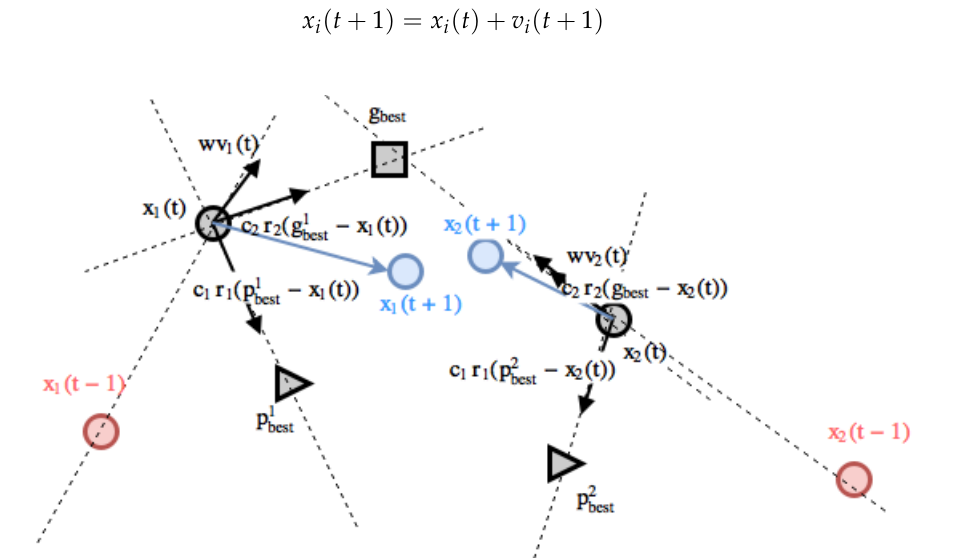
Figure 6. Particle swarm optimization model: position update using a star topology ( g best ) and an inertia w term. Please note that g best , p 1 and p 2 are fixed in time t in order to make the figure as best best simple as possible, their position could change (or not) depending on the fitness value of particles x 1 and x 2 along time in a real example.